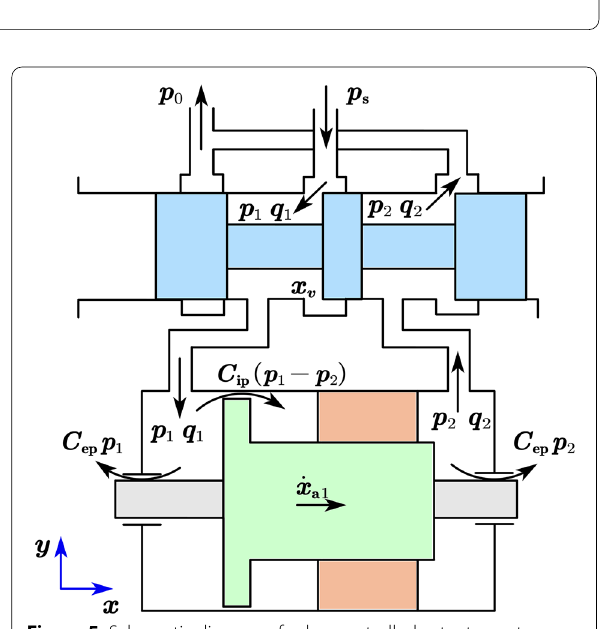
Figure 5 Schematic diagram of valve-controlled actuator